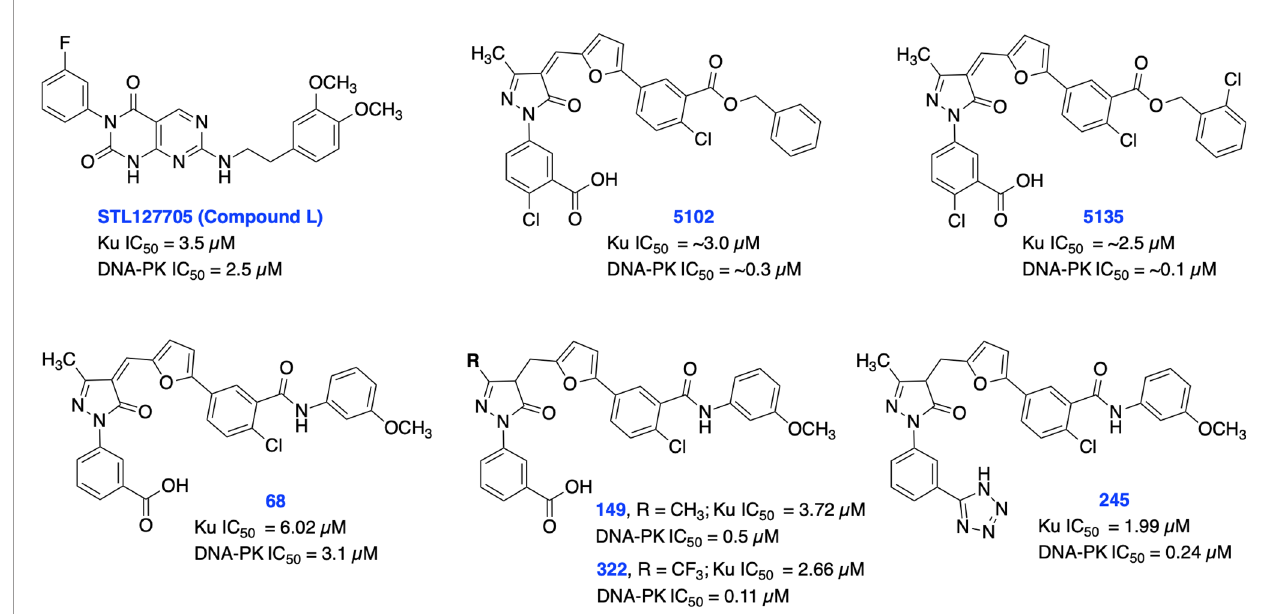
FIGURE 3 | Small molecule inhibitors of Ku70/80 and their respective IC50 values for disruption of DNA-binding by Ku70/80 and DNA-PK